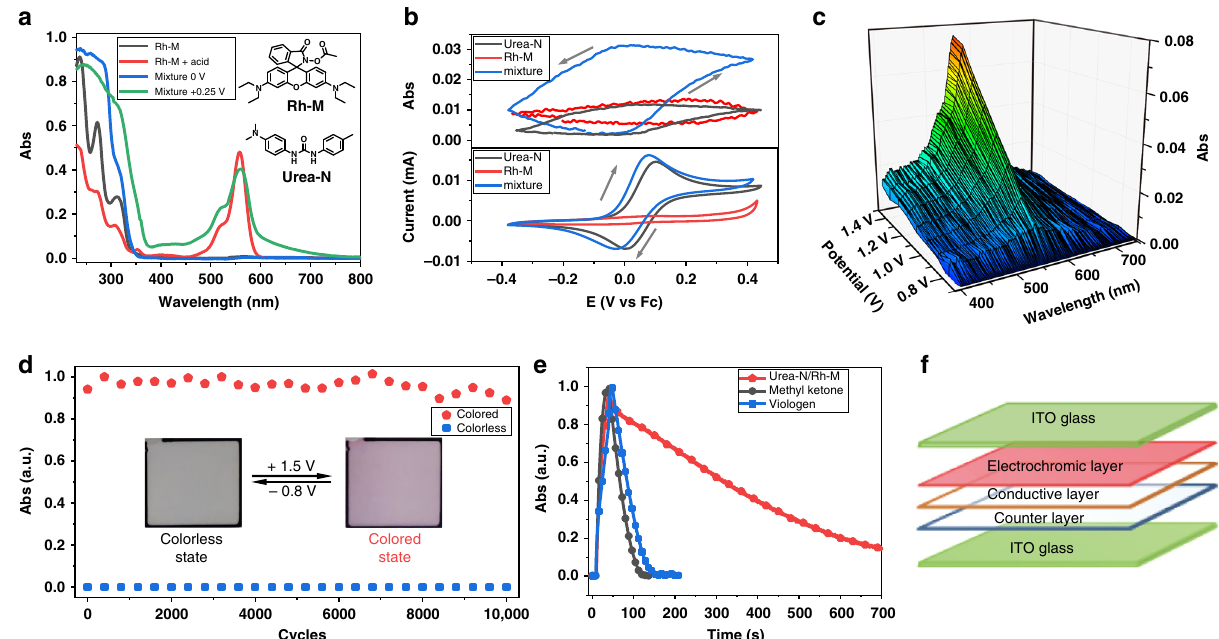
Fig. 1 Feasibility and device properties of the “ Urea-N + Rh-M ” electrochromic system. a UV-vis spectra of Rh-M (black, 1.0 × 10 − 4 mol L − 1 ), Rh-M (1.0 × 10 − 5 mol L − 1 ) treated with CF 3 COOH (red), “ Urea-N + Rh-M ” (blue, Rh-M : 1.0 × 10 − 4 mol L − 1 , Urea-N : 1.0 × 10 − 4 mol L − 1 ), and “ Urea-N + Rh-M ” under + 0.25 V vs. Ag/AgNO 3 (green, Rh-M : 1.0 × 10 − 4 mol L − 1 , Urea-N : 1.0 × 10 − 4 mol L − 1 ). b Changes in absorption at 560 nm (top) during CV (bottom) of Urea-N (1.0 × 10 − 3 mol L − 1 ), Rh-M (1.0 × 10 − 3 mol L − 1 ) and “ Urea-N + Rh-M ” (1.0 × 10 − 3 mol L − 1 /1.0 × 10 − 3 mol L − 1 ) in acetonitrile at 20 mV s − 1 . c 3-D spectroelectrochemical diagram of “ Urea-N + Rh-M ” solution at + 0.8 V – + 1.5 V for 15 s in liquid device. d The stability at 560 nm of the “ Urea-N + Rh-M ” liquid device (10000 cycles). e The optical memory of liquid devices of “ Urea-N + Rh-M ” (red), methyl ketone (black), and viologen (blue) at 560 nm after the electrochromic stimuli are cut off. f Structure of the semi-solid bistable electrochromic